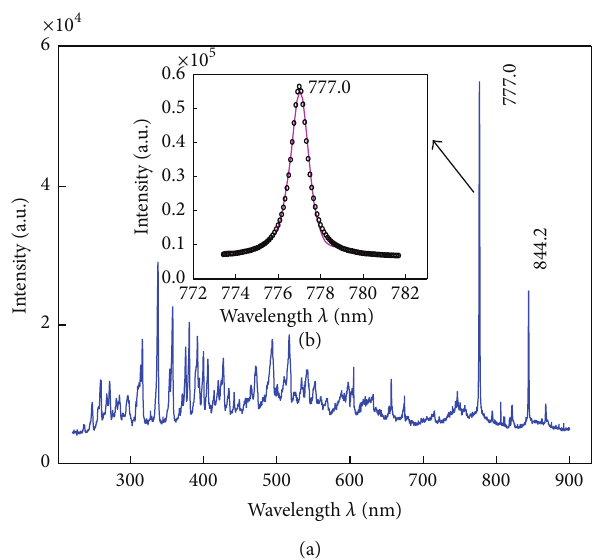
Figure 2: (a) Emission spectra detected from the pulse discharged instrument; (b) Lorentz fitting for the emission spectra of O atoms at 777.0 nm.